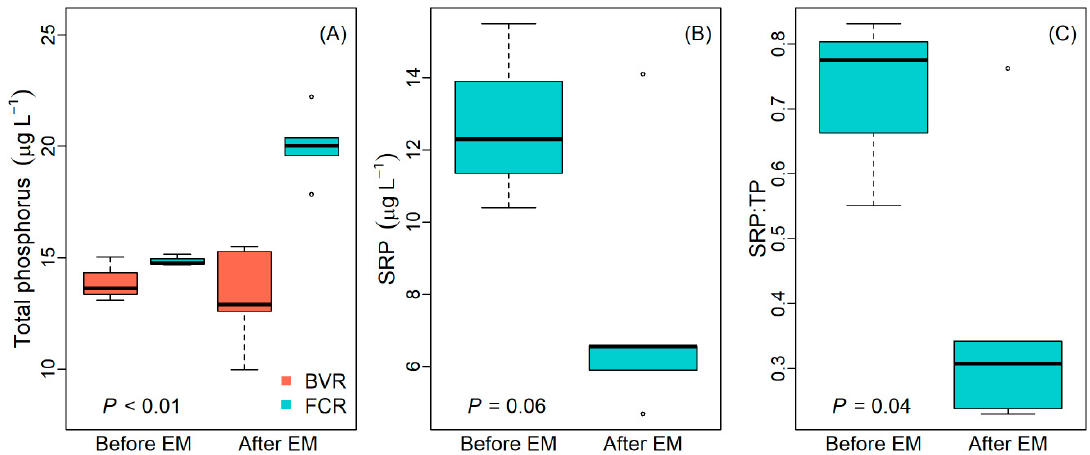
Figure 8. ( A ) Volume-weighted total phosphorus (TP) in the epilimnion of both Falling Creek Reservoir (FCR, blue) and Beaverdam Reservoir (BVR, orange) during the 2 weeks before and after EM1; ( B ) soluble reactive phosphorus (SRP) at the depth of fluorescence maximum (F max ) in FCR in the 2 weeks before and after EM1; and ( C ) SRP:TP at the depth of F max in FCR in the 2 weeks before and after EM1.